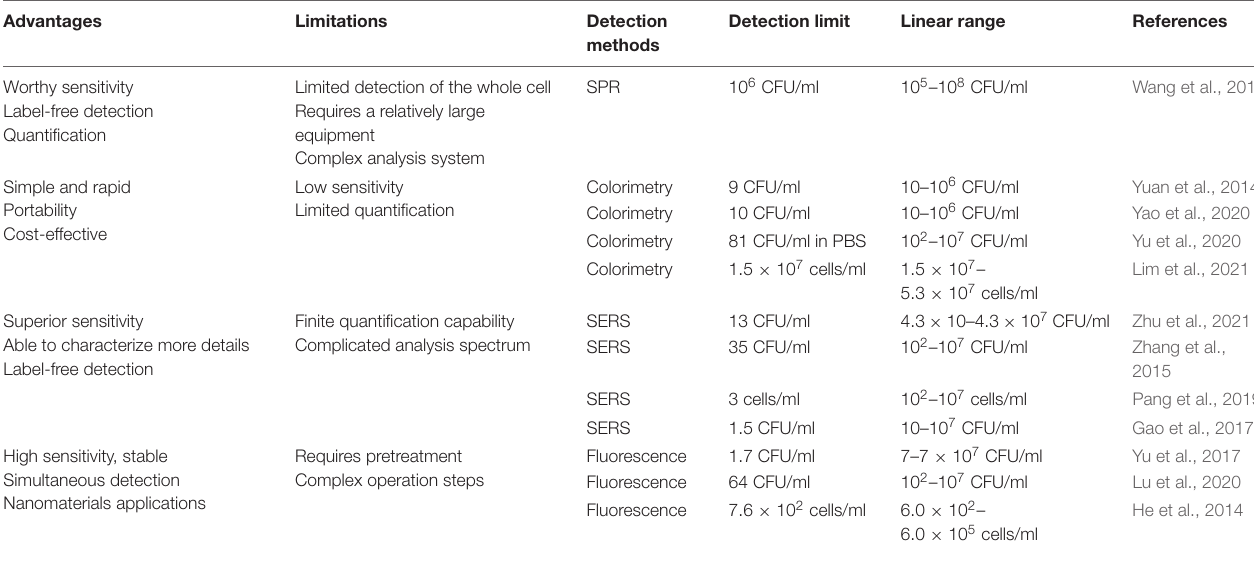
TABLE 2 | Optical-based aptasensors for detect S. aureus